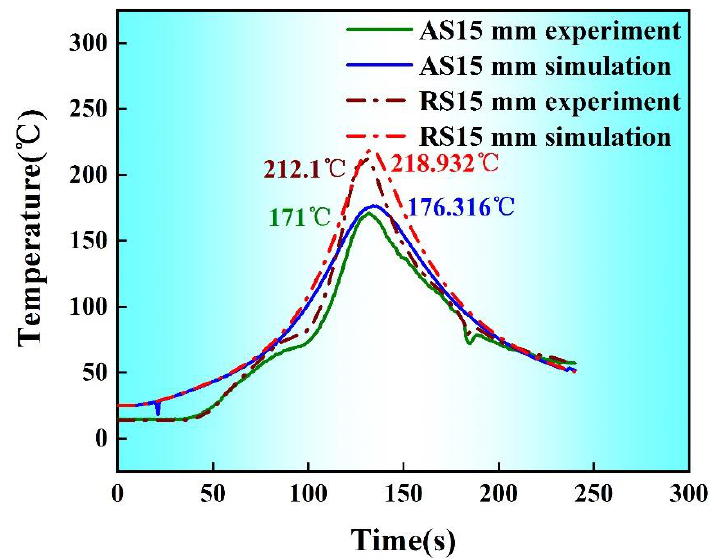
Figure 5. Comparison between the simulated thermal cycle curves and the measured results under typical welding parameters. typical welding